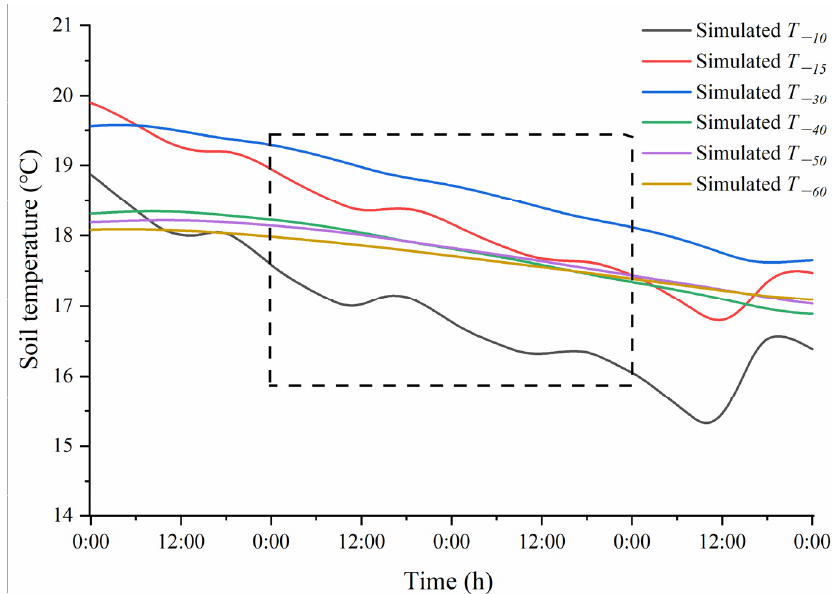
Figure 25. Soil temperature at different depths on snowy winter days (dashed box represents the soil temperature on cloudy days, Z = − 30 m).